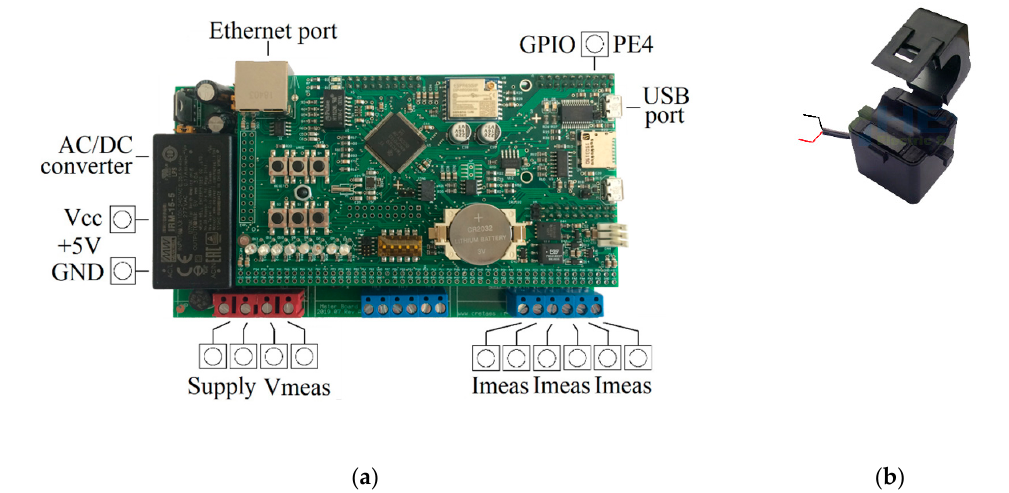
Figure 6. Connection of smart meter at a user’s home.